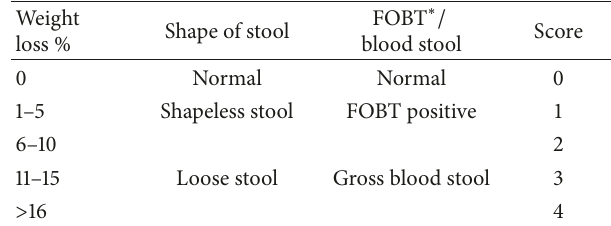
Table 1: DAI assessment (disease activity